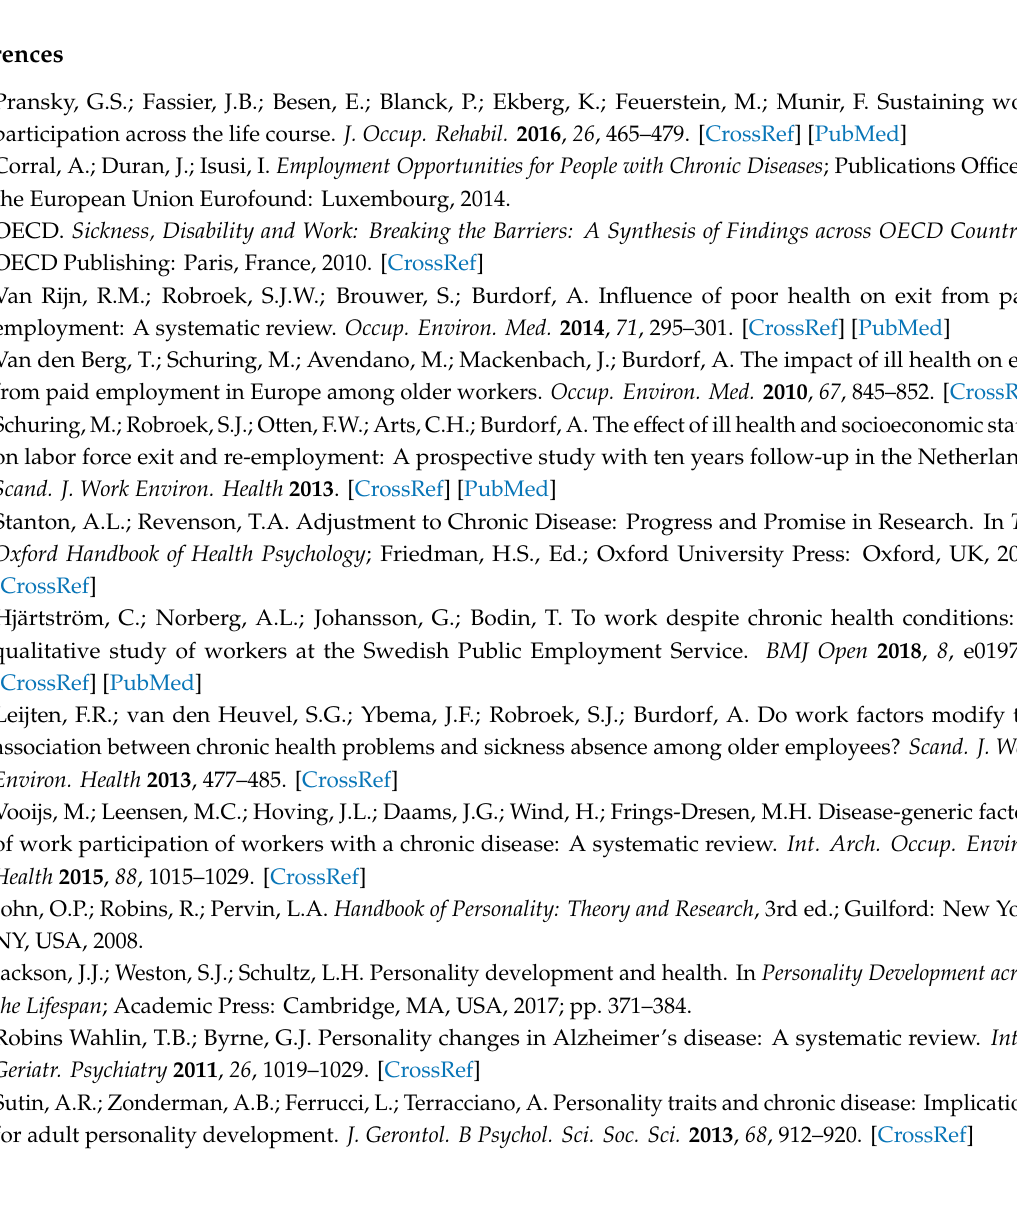
Table S1: Correlations between personality facets of the NEO-PI-R and other baseline characteristics. Figure S1: Flow chart of the analytic study sample. Table S2: Associations of personality facets and labor market attachment among individuals with at least one chronic health condition, corrected for sociodemographic factors, multi-morbidity (model 1) and self-rated health (model 2) ( n = 21,173). Table S3: Associations of personality facets and labor market attachment among individuals with at least one chronic health condition stratified by chronic disease and corrected for sociodemographic factors and multi-morbidity; odds ratios with their corresponding 95% confidence intervals. Table S4: Associations of personality facets and employment status among individuals with at least one chronic health condition stratified by chronic disease and corrected for sociodemographic factors, multi-morbidity and self-rated health; odds ratios with their corresponding 95% confidence